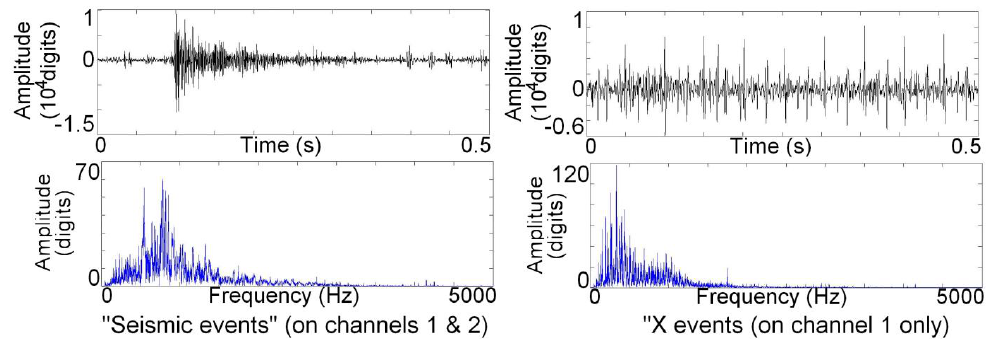
Figure 3 – Examples of characteristic ‘seismic’ and ‘X’ event records. 3 Fig. 3. Examples of characteristic “seismic” and “X” event